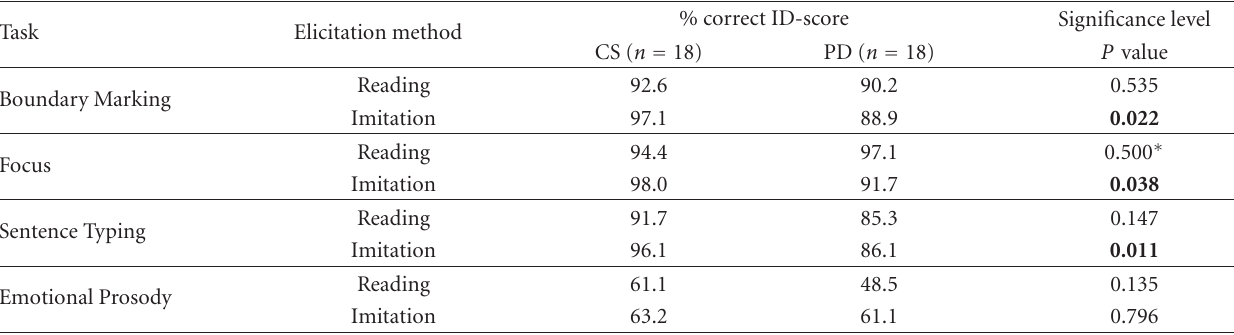
Table 4: Results for 2 speaker groups: % correct identification scores and P values resulting from χ 2 test (statistically significant P values in bold print).